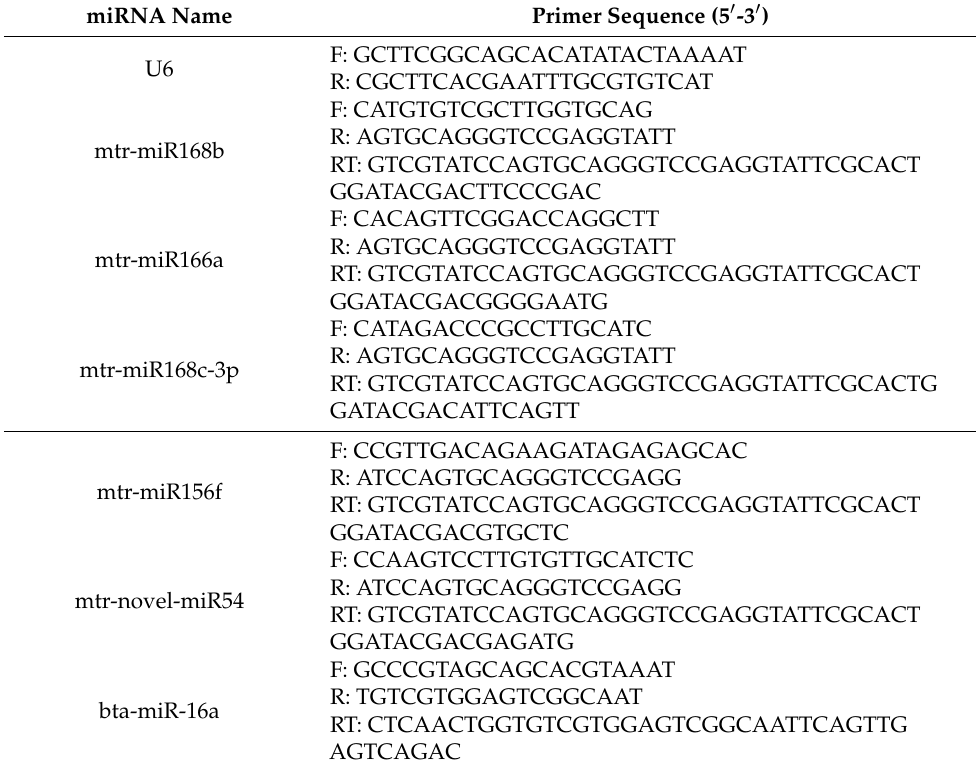
Table 3. Primer sequences of